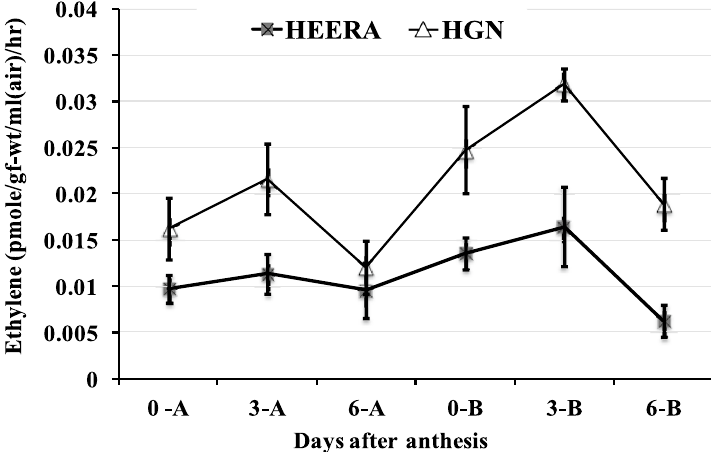
Figure 2. Ethylene production in apical and basal spikelets of compact panicled cultivar PDK Shriram (HGN) and lax-panicled cultivar Heera on different days after anthesis (0, 3 and 6). The data are the mean (± SD) of five observations. There was significant difference (p ≤ 0.05) for the ethylene production between apical and basal spikelets in HGN. A denotes apical spikelets; B denotes, basal spikelets.